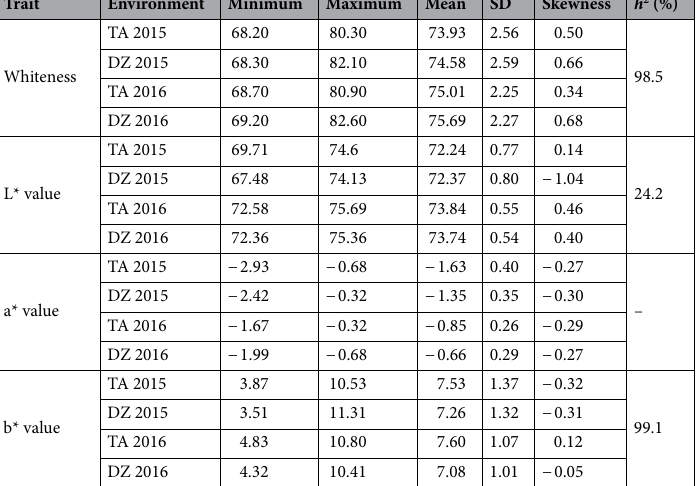
(Table S2). The phenotypic value of flour whiteness associated with BS00000020_51-C on chromosome 5D was significantly higher than that associated with BS00000020_51-T across all four environments, indicating that the contribution of BS00000020_51- C locus to flour whiteness was better than that of BS00000020_51-T locus (Table S2). In total, 6 SNP loci on chromosomes 1B, 2D, 3A, 5B, 5D and 6A were associated with flour colour brightness (L* value) (P < 10 –4 ) (Table 4; Fig. 1). Three SNP loci ( Kukri_c33486_128, BS00000020_51, and GENE-4011_91 ) were identified in more than one environment. The BS00000020_51 locus located on the 5D chromosome was detected in the four environments, with a maximum PVE of 12.28%. Alleles C and T of marker BS00000020_51 were associated with the largest phenotypic differences (0.57) (Table S2).